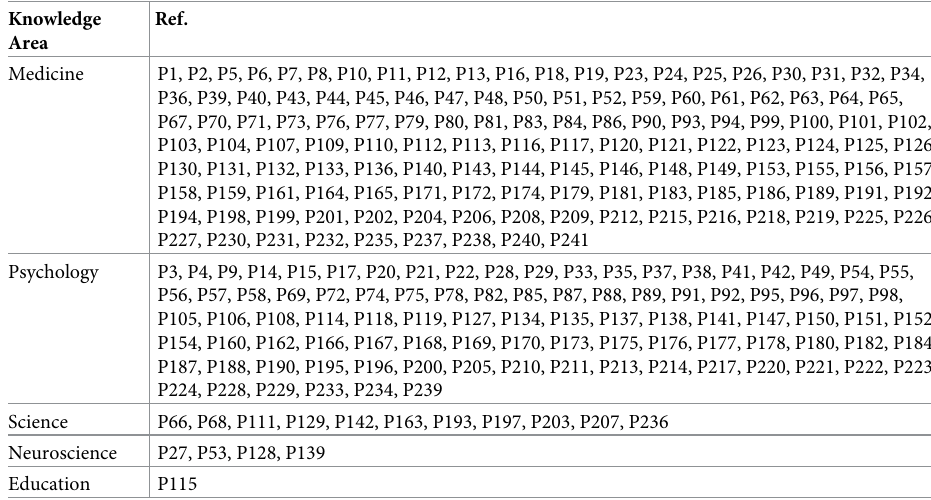
Table 2. References by journal knowledge